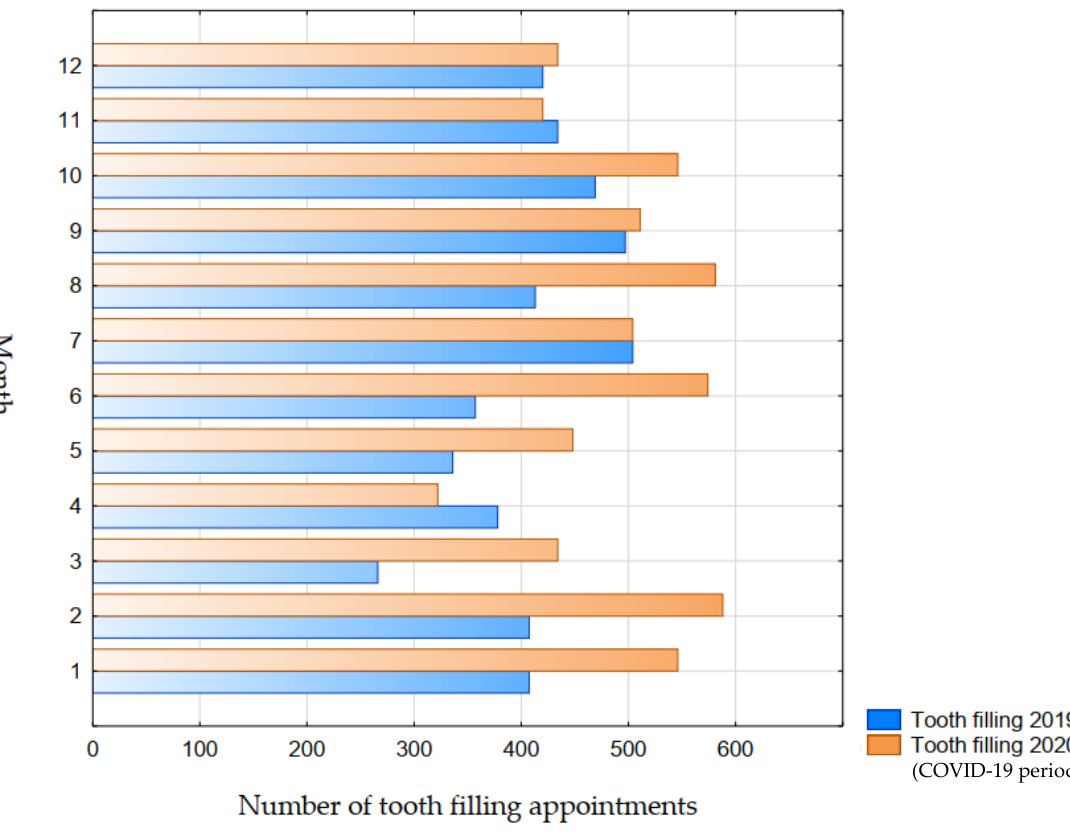
Figure 8. Change in the number of tooth filling appointments during the pandemic period from the prepandemic period.